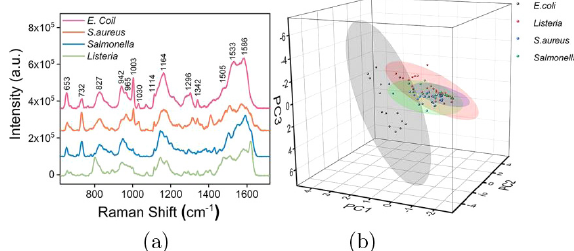
Fig. 7. (a) Comparison of SERS spectra of four foodborne pathogenicbacteriaonHfTe 2 -Ausubstrate.(b)Three-dimensional PCA scores plot of E. coli , S. aureus , Salmonella and Listeria